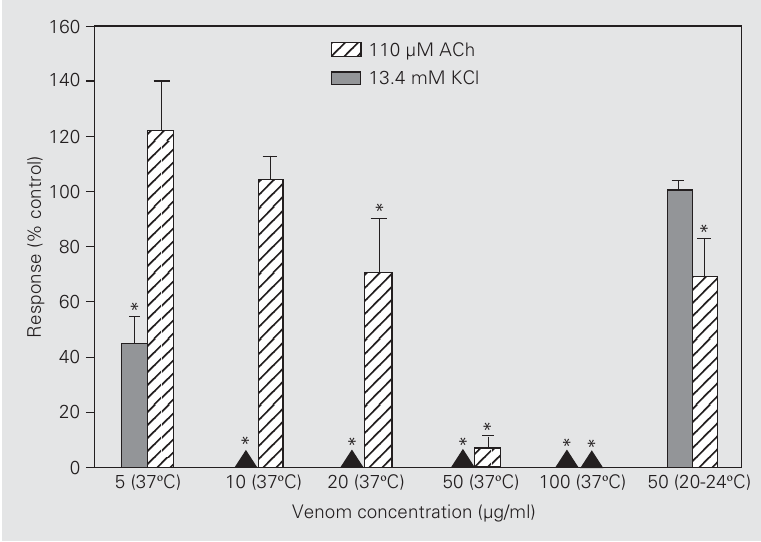
Figure 3. Effect of Bothrops neuwiedii pauloensis venom on muscle contractions induced by 13.4 mM KCl and 110 µM acetylcholine (ACh) in the chick biventer cervicis preparations after 120-min incubation compared to the responses observed in Krebs controls (100%). Data are reported as means ± SEM for 3-6 experiments per concentration. The preparations were incubated with venom at the concentrations and temperatures indicated on the histogram. The triangles on the X-axis indicate that the venom totally blocked the response to the agonist. *P<0.05 compared to the corresponding control (Krebs solution alone) (Student t